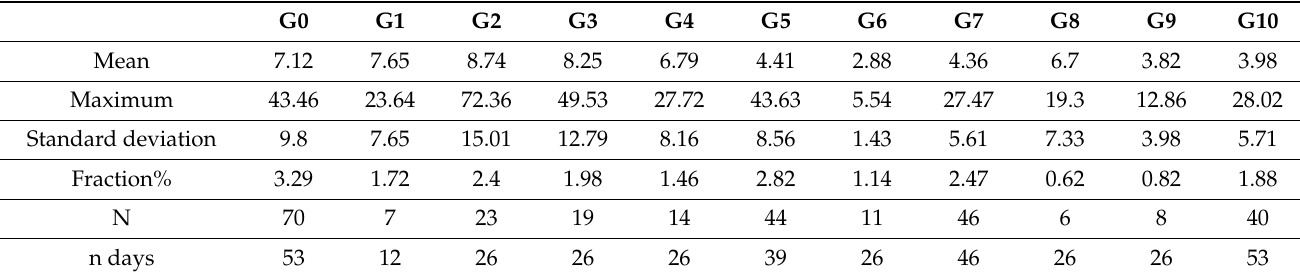
Table 1. Summary of non-zero rainfall intensities from all rain